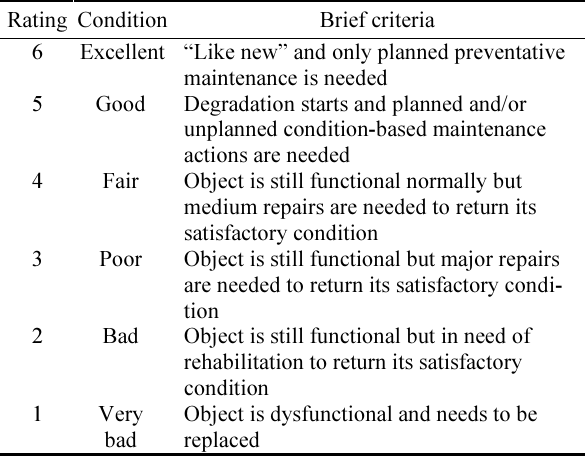
Table 1. Building condition assessment table (Modified based on Straub 2009; Mc Duling 2006; Barry